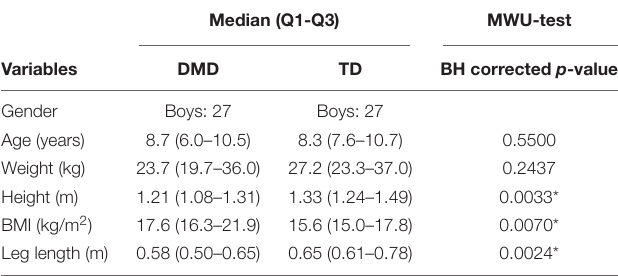
TABLE 1 | Subject characteristics of boys with DMD at baseline and TD children, and results from MWU-test. Median